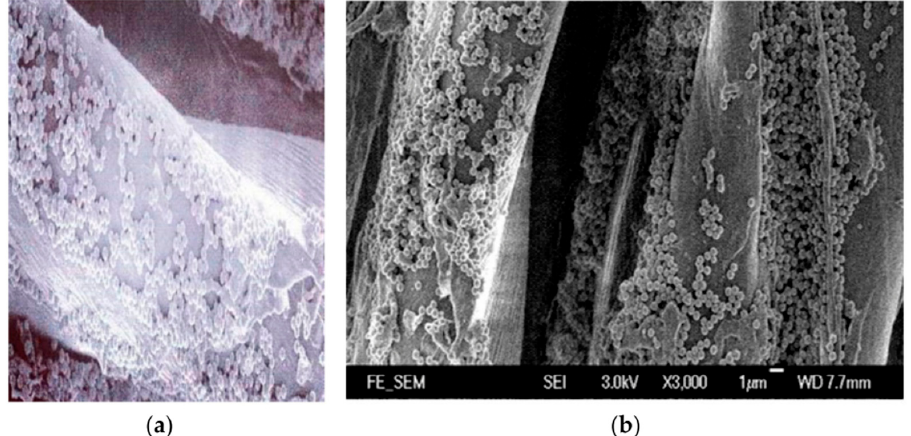
Figure 13. ( a ) Medical textile fibers coated with Ag nanoparticles. ( b ) Medical fabrics using TiO 2 - nanoparticle-treated fibers. Reprinted with permission from [95]. Copyright 2021 MDPI. Distributed under Creative Commons Attribution-based license (CCBY 4.0.).